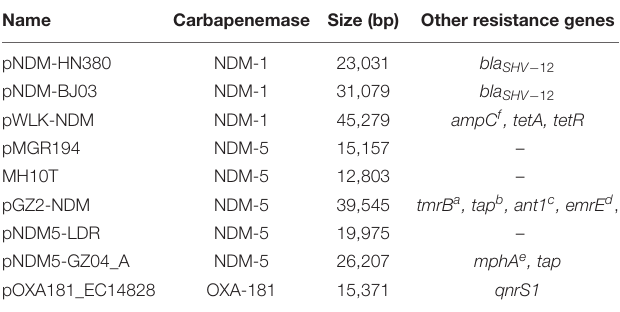
TABLE 1 | IncX3 plasmid gene load